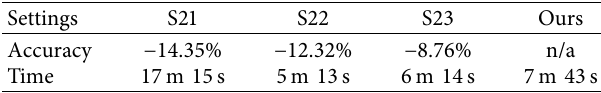
Table 4: Accuracy decrement ( − )/increment (+) and time cost of different algorithms on our adopted data set.